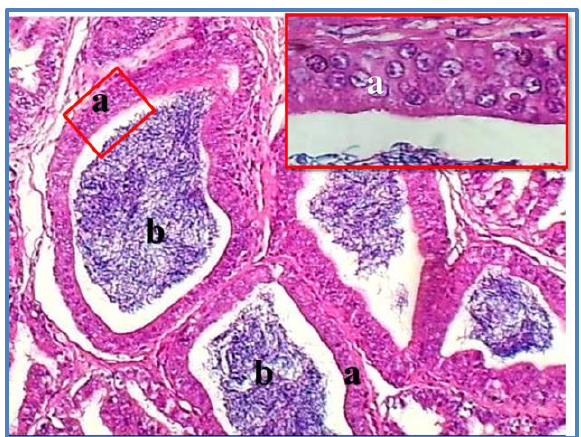
Figure,2: Histological section of epididymal duct showing a- pseudostratified columnar epithelium b- lumen of epididymal duct full with spermatozoa H&E stain (40x)